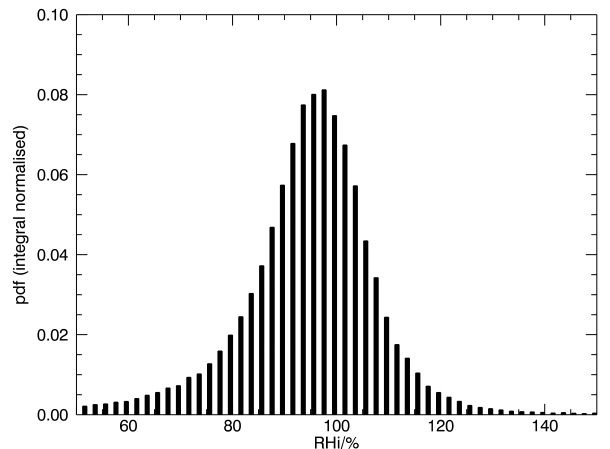
Figure 9. Frequency distribution of the relative humidity over ice at different vertical layers inside the cirrus cloud shown in Figs. 3 and